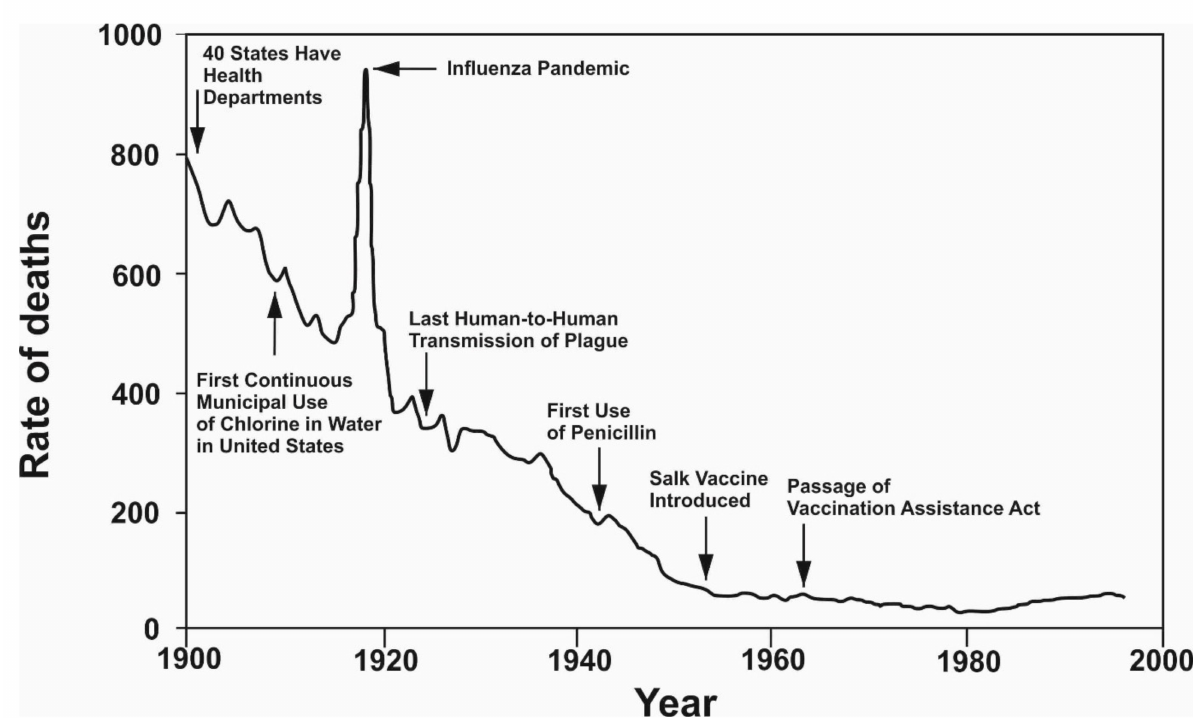
Figure 3. Death rate per 100,000 inhabitants per year from water related infectious diseases in the USA from 1900 to 1996 (Adapted from